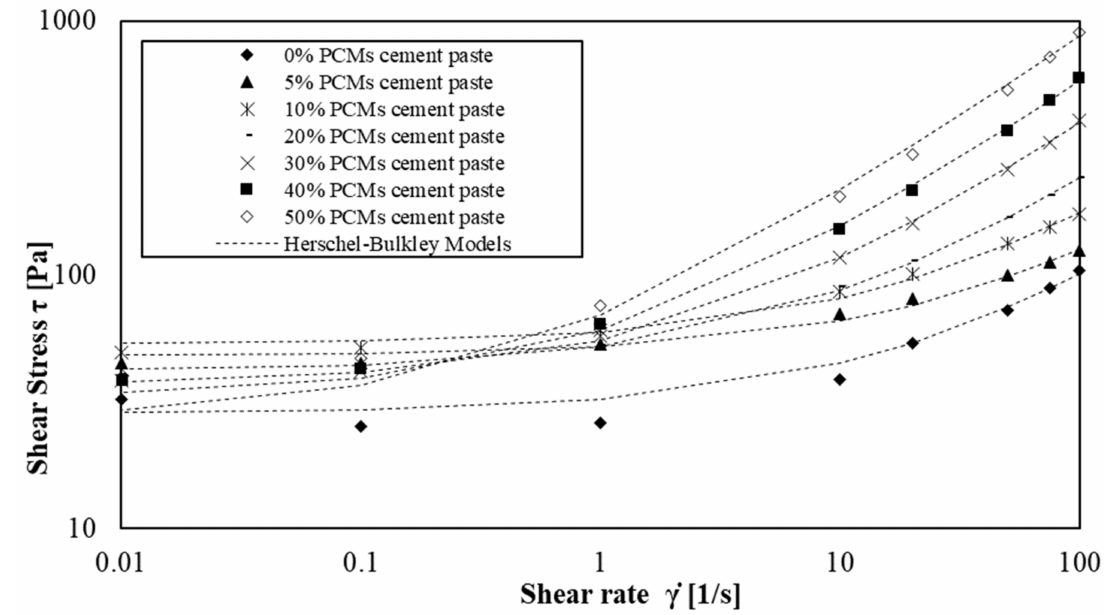
Figure 9. Shear flow curves of cement paste with amount of s/s PCMs ranging 0 wt% to 50 wt%.